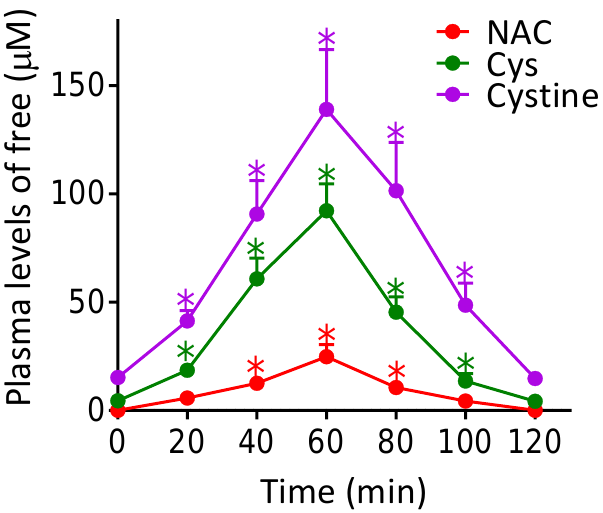
Figure 3. Effect of NAC administration on the plasma levels of free NAC, Cys and cystine. NAC (240 mg/kg) was administered orally to mice bearing B16-F10 xenografts starting 5 days after tumor inoculation. NAC, Cys and cysteine levels were determined by reversed-phase high-pressure liquid chromatography, as explained under Materials and Methods, 15 days after tumor inoculation. Data are mean values ± SD, n = 5–6 determinations per molecule and time point. * Significantly different p < 0.01, comparing data for NAC at 40–100 min versus NAC levels at 20 min; comparing data for Cys and cysteine levels at 20–120 min versus control levels of Cys and cysteine at 0 min (n = 7 in each case).